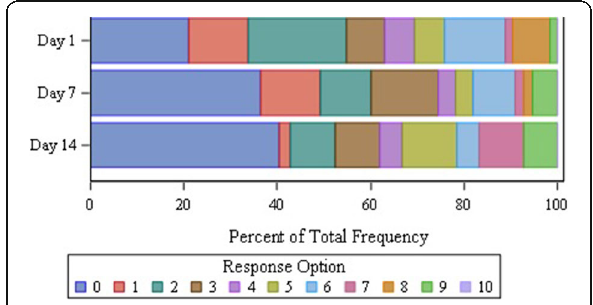
Fig. 3 Item Distribution for the Skin Pain NRS and Floor-Ceiling Effects of the Response